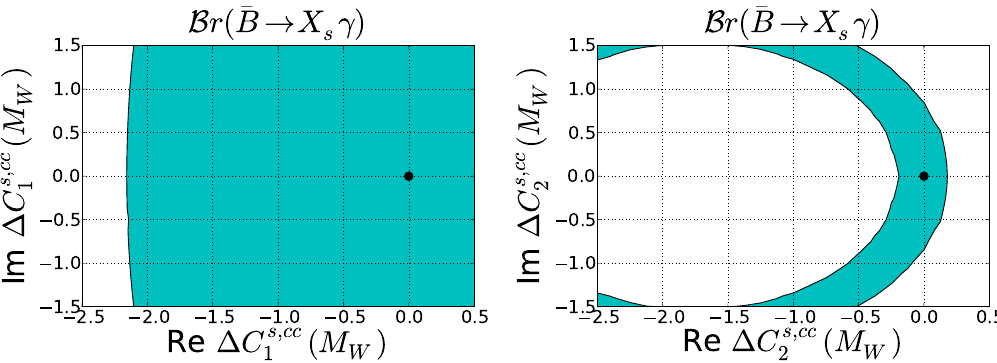
Figure 11 . Potential regions for the NP contributions in (cid:1) C s;cc